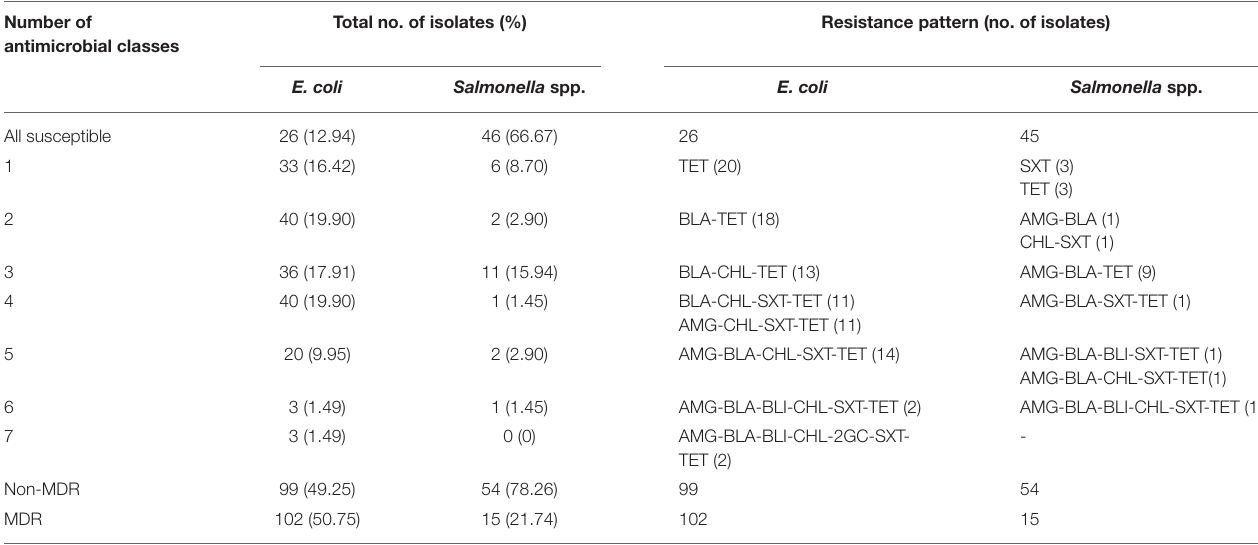
TABLE 3 | Resistant and MDR profiles with the highest frequency in E. coli ( n = 201) and Salmonella spp. ( n = 69). Number of Total no. of isolates antimicrobial classes